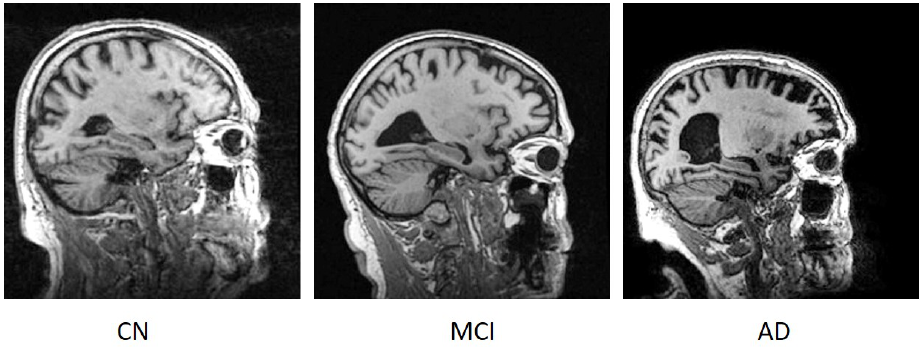
Figure 1. Sample brain MR image of a CN, MCI, and AD